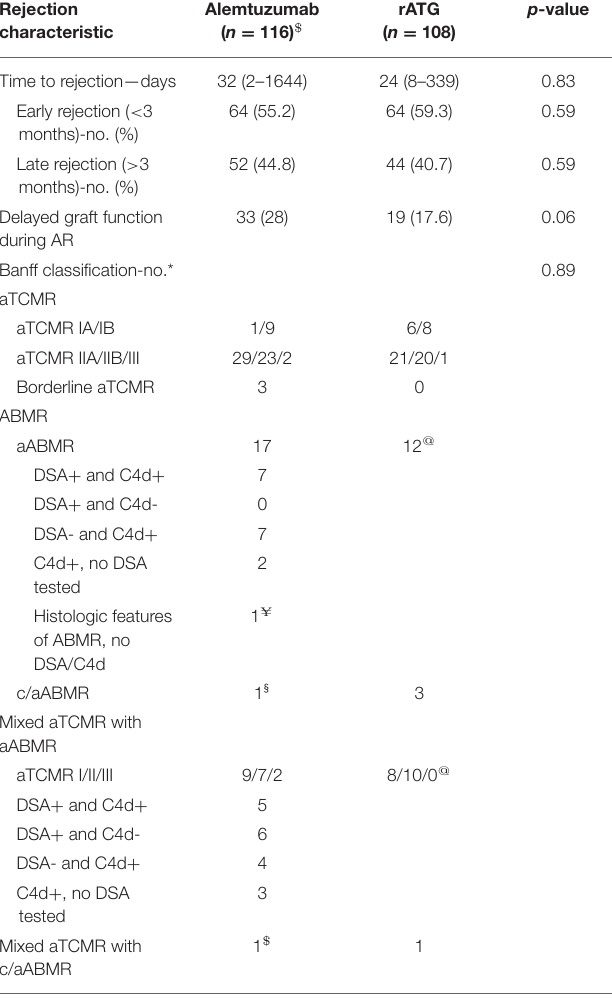
TABLE 3 | Rejection